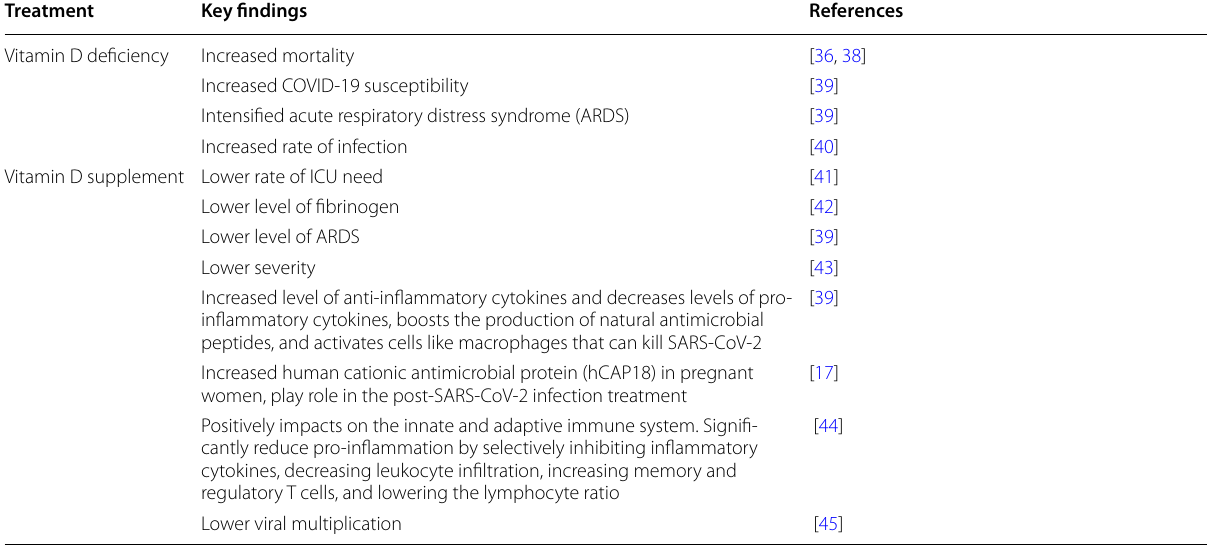
Table 2 Effectiveness of vitamin D supplement in COVID-19 treatment in different populations Treatment Key